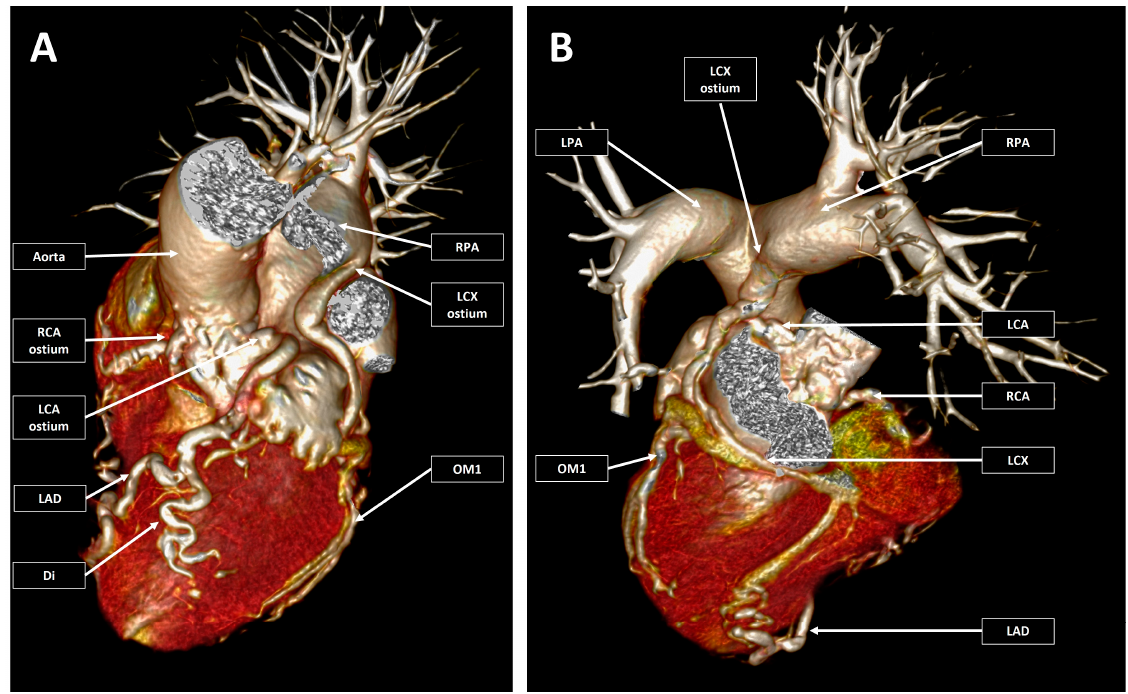
Figure 2. 3D virtual rendering technique reconstruction of the heart, main vessels, and coronary arteries. Pannel ( A ) (left) Left/cranial double oblique anterior reconstruction with the main pulmonary artery and the left pulmonary artery removed from the image. Pannel ( B ) (right) Right/cranial double oblique posterior reconstruction with the removal of the atria, ascending aorta, aortic arch, and descending aorta. The coronary arteries are enlarged and had a tortuous course. There were both left and right coronary arteries emerging from the corresponding coronary sinuses, and a circumflex coronary artery emerged from the right pulmonary artery. RCA—right coronary artery; LCA—left coronary artery; LAD—left anterior descending coronary artery; Di—diagonal branch; LCx—left circumflex coronary artery; OM1—first obtuse marginal; LPA—left pulmonary artery; RPA—right pulmonary